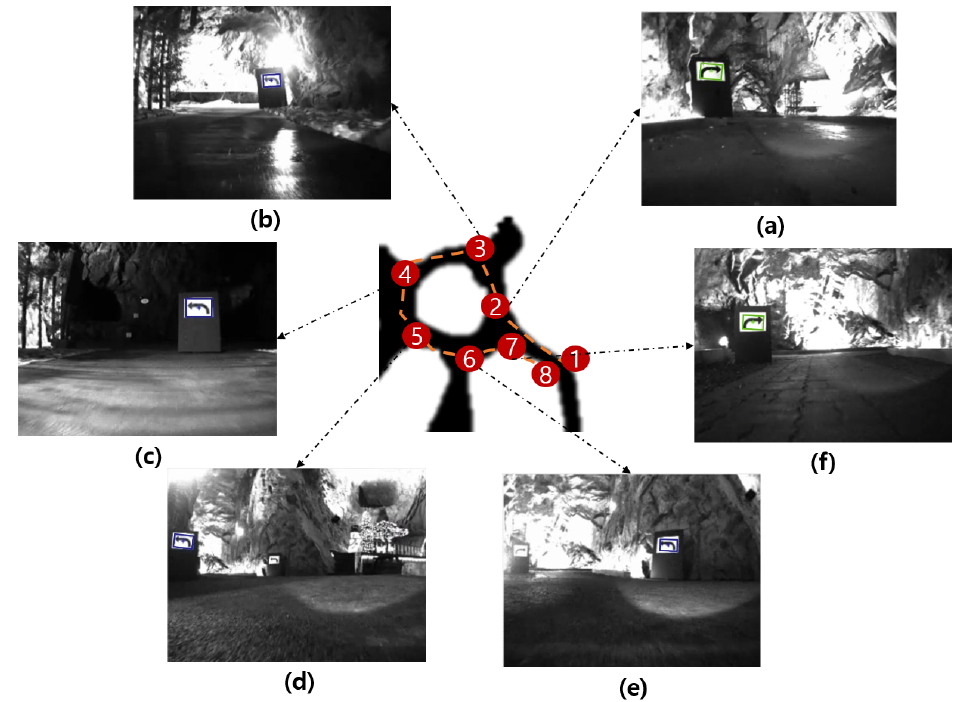
Table 2. Field experimental results of autonomous driving robot for recognizing the road signs in the underground mine.